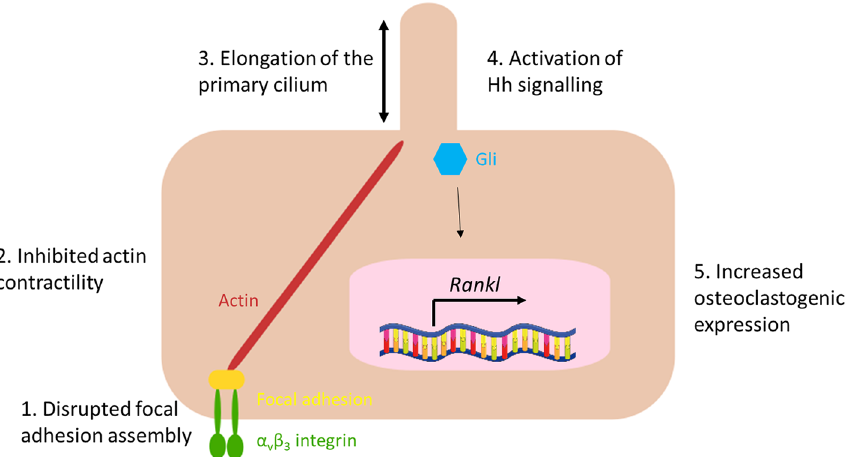
Figure 8. A schematic depicting the proposed effect of estrogen withdrawal, α v β 3 antagonism, and actin contractility inhibition (Y27632) on the primary cilium and associated signalling. Following estrogen withdrawal, (1) focal adhesion assembly becomes disrupted and (2) actin contractility is inhibited, followed by (3) an elongation of the primary cilium, and resulting in (4) activation of Hedgehog signalling, and (5)